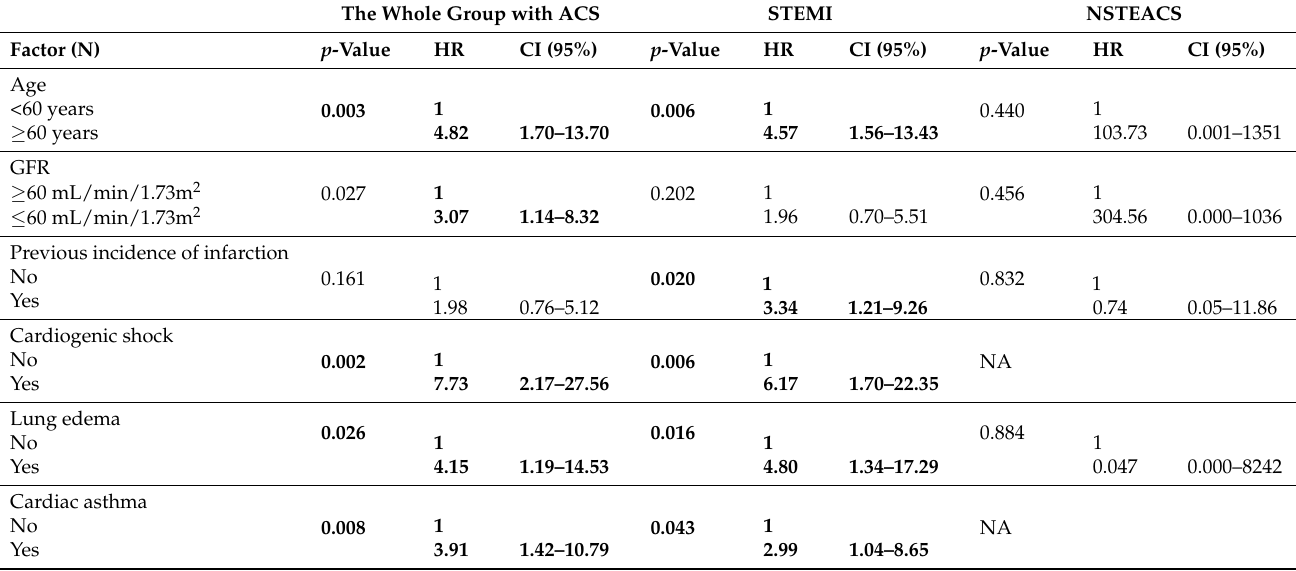
Table 7. Univariate Cox’s proportional analysis of the short period survival (one year) of patients with acute coronary